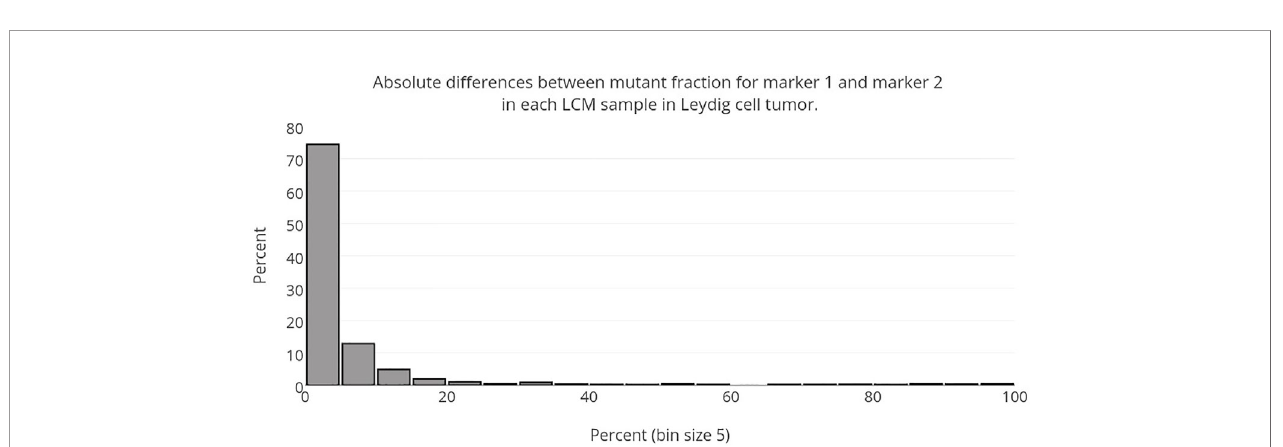
FIGURE 8 | The absolute value of the difference between the mutant fraction of marker 1 and marker 2 is taken for each LCM sample of the Leydig cell tumor. The histogram is then made with the resulting values. As can be seen, the majority of the values cluster around a difference of 0, which demonstrates the strong similarity between the two observed mutant fractions across the whole